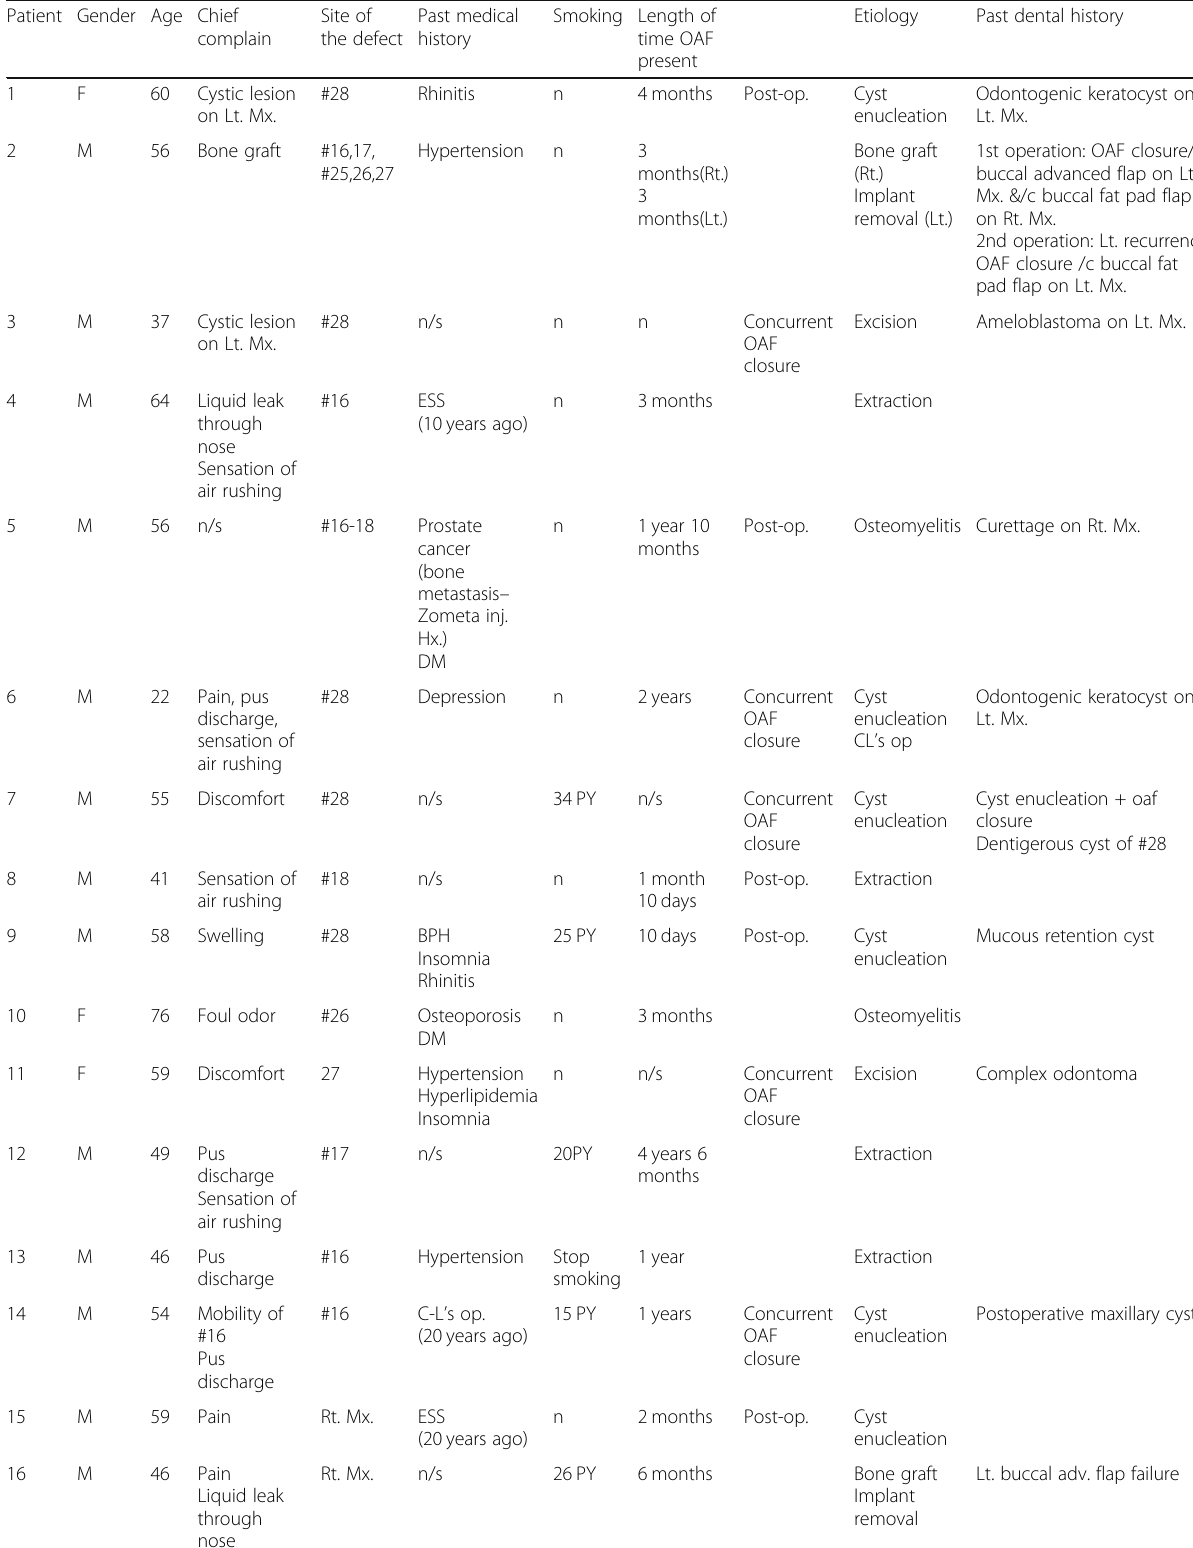
Table 1 Summary of clinical details Patient Gender Age Chief